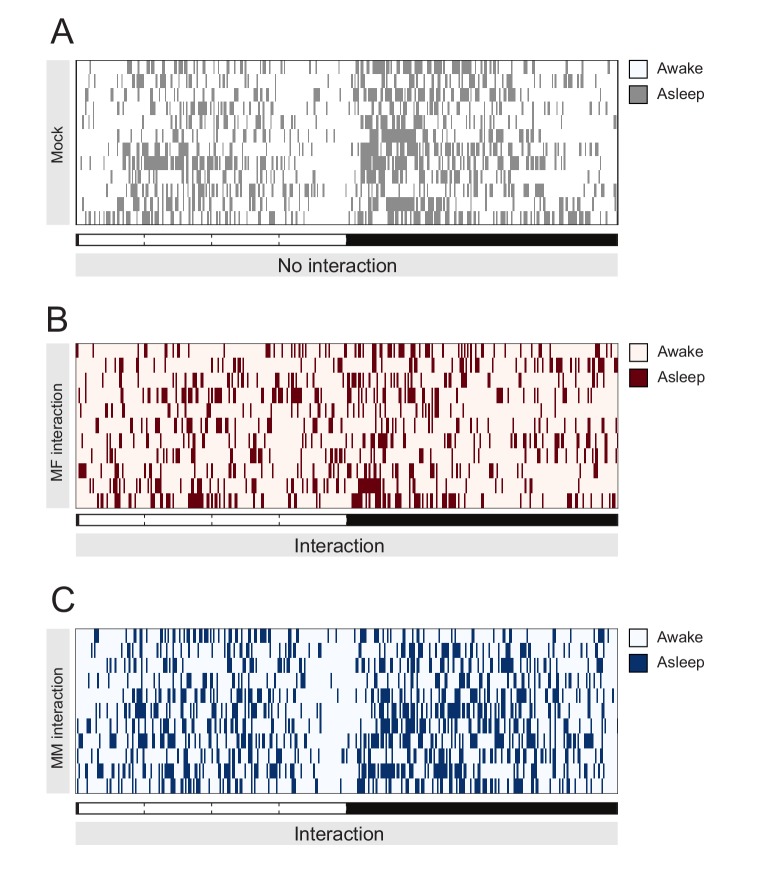
Human assisted behavioural scoring of single fly sleep in Mock, solitary condition (A), during MF interaction (B), or MM interaction (C) to validate automatic scoring.Fly position was scored once every 240 s and bins with movement smaller than half a fly body size (30 pixels) were scored as asleep. Each row shows data for a single male fly.